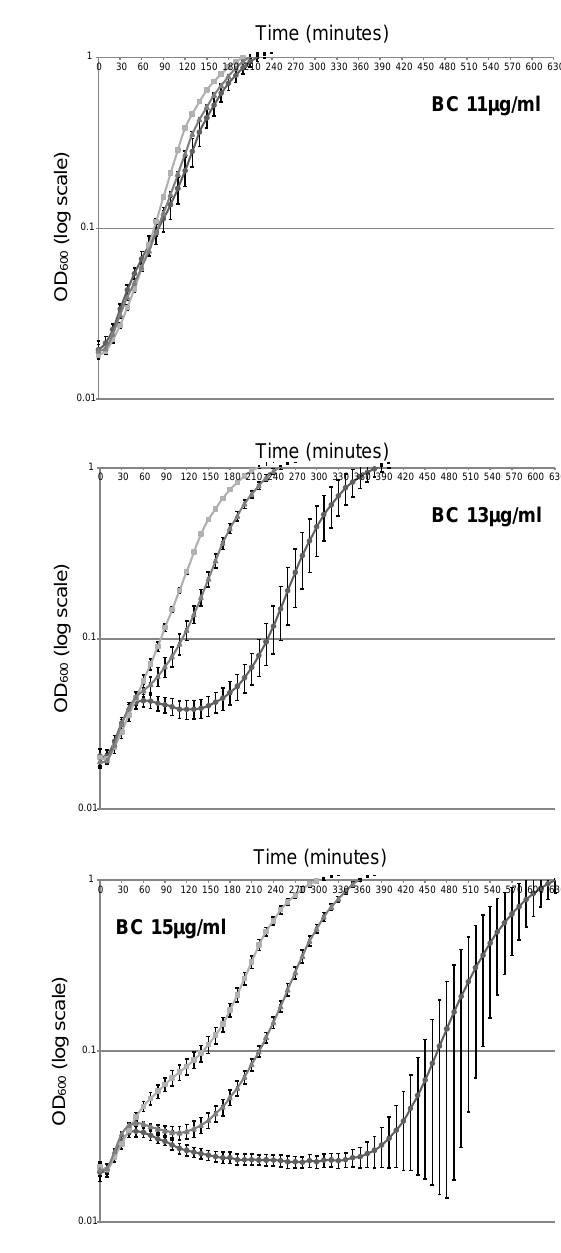
Figure 5. Growth curves (OD—log scale) of the Control (circle symbols), M95 (square symbols) and M100 (triangle symbols) in Bioscreen exposed to BC (0, 11, 12, 13, 14 and 15 µg/mL). The vertical bars represent the standard deviation of the ten replicates (10 wells per sample and concentration).